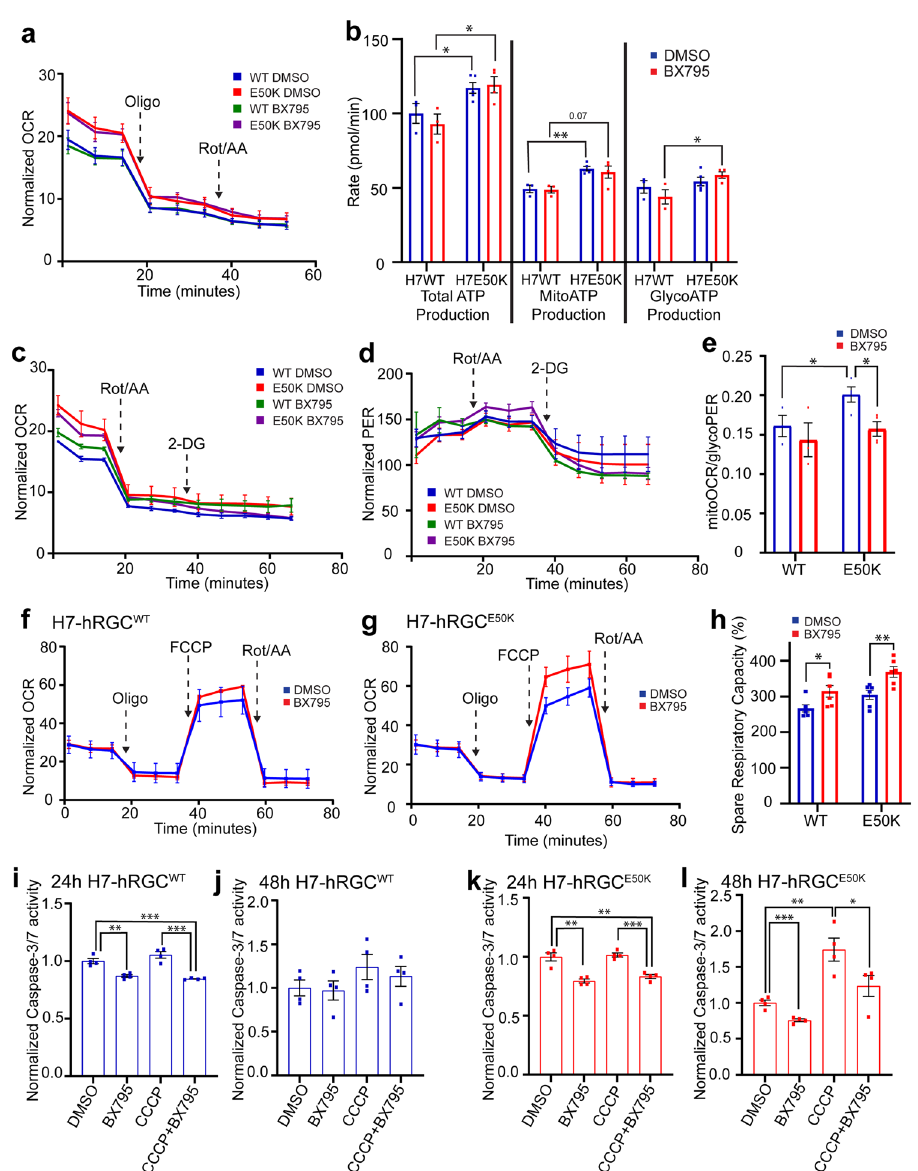
Fig. 6 BX795 mediated TBK1 inhibition restores energy homeostasis and provides neuroprotection in glaucomatous hRGCs. a Measurements of cell area normalized OCR from the ATP rate assay of hRGCs treated with DMSO or 1 μ g/ml BX795 for 24 h. b Calculated total-, mito-, and glyco- ATP production rates from the ATP rate assay. n = 3 – 5. c , d Measurements of cell area normalized c OCR and d PER from the glycolytic rate assay. e Calculated mitoOCR/glycoPER from the glycolytic rate assay. n = 3 – 4. f , g Measurements of cell area normalized OCR from the Mito Stress Test of f H7-hRGC WT and g H7-hRGC E50K , and h spare respiratory capacity after 24h treatment with 1 μ g/ml BX795. n = 6. i – l Caspase-3/7 activity was measured using ApoToxGlo-Triplex assay kit in hRGCs after 16 h pretreatment with BX795 and then 24 h or 48 h treatment with DMSO, 1 μ g/ml BX, 10 μ M CCCP, or BX795 and CCCP treatments. Treatment conditions were normalized to the DMSO control for respective hRGC type. ٭ p -value < 0.05, ٭٭ p -value < 0.01, ٭٭٭ p -value < 0.001. Unpaired student ’ s t- test between independent datasets. Error bars are